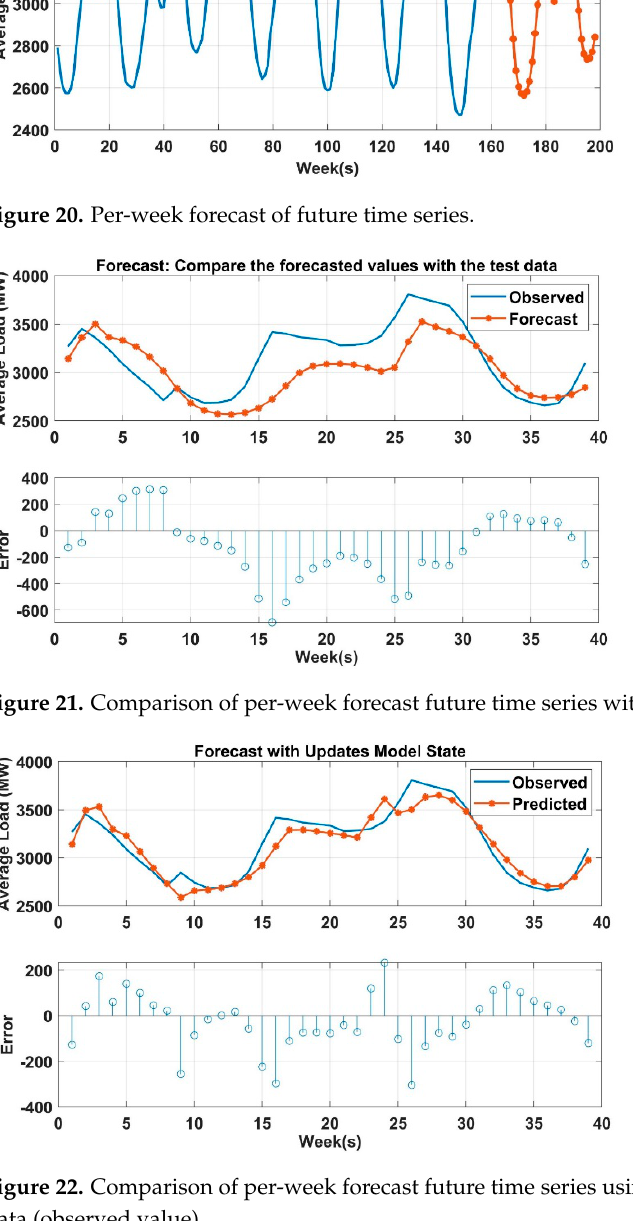
Figure 22. Comparison of per-week forecast future time series using updated DNN model with test data (observed value).